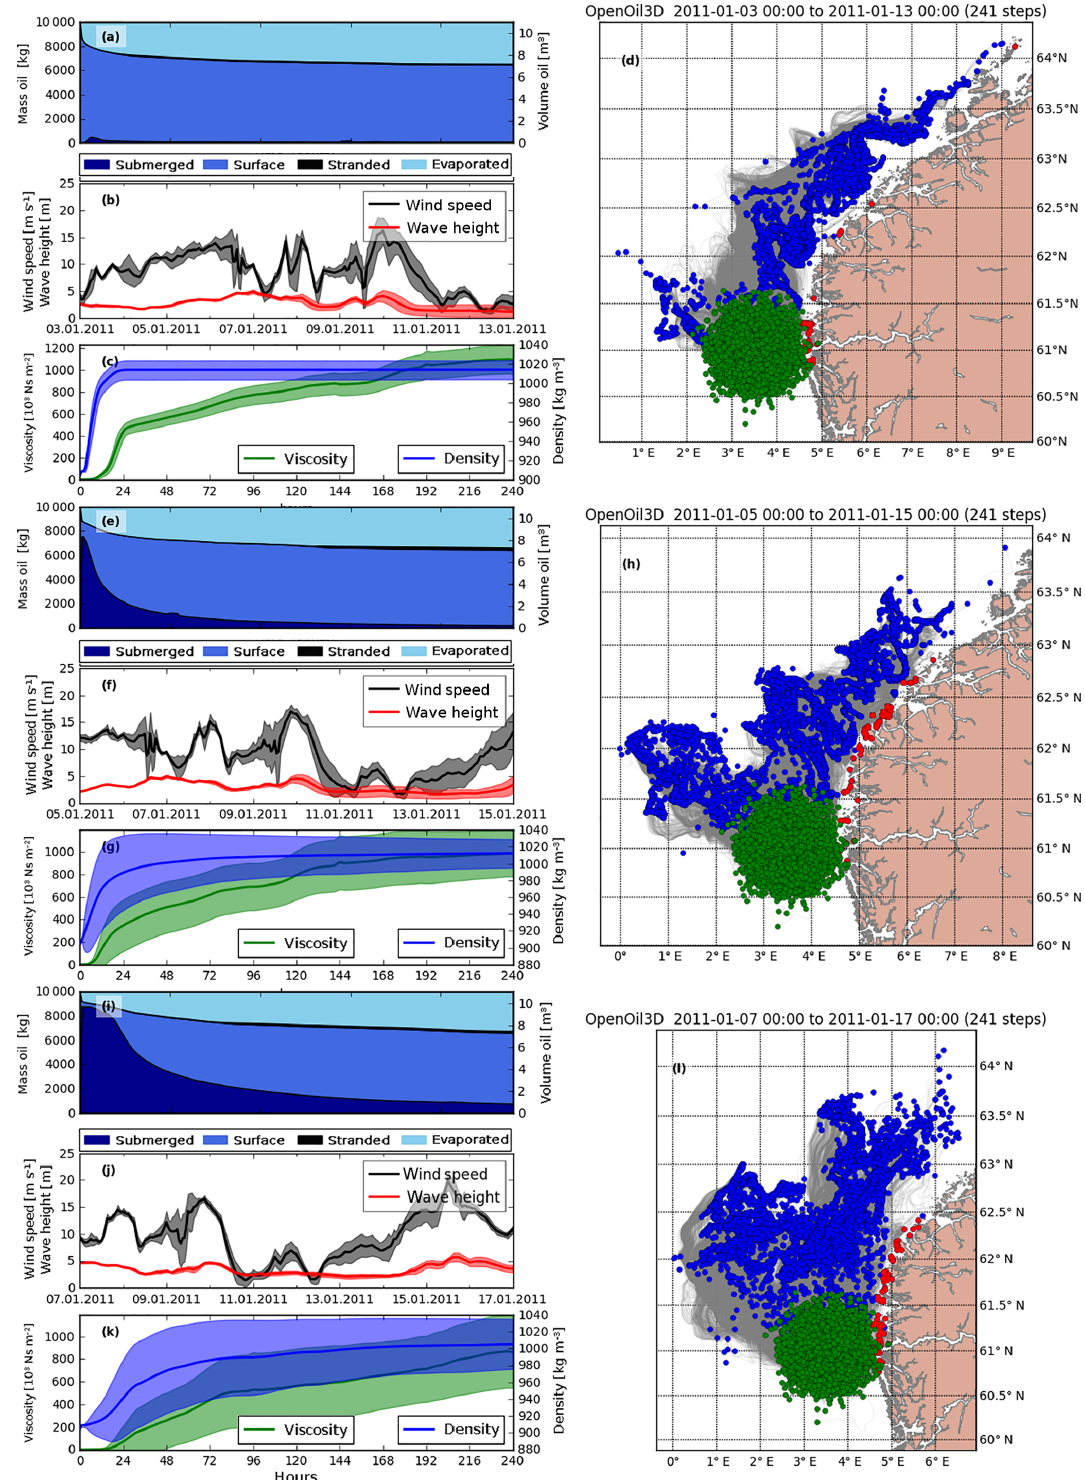
Figure 4. Three oil drift simulations with different start dates using the same oil type Oseberg A. The start dates between each simulation are 2 days apart and each simulation lasts for 10 days. The panels are organized as in Fig.